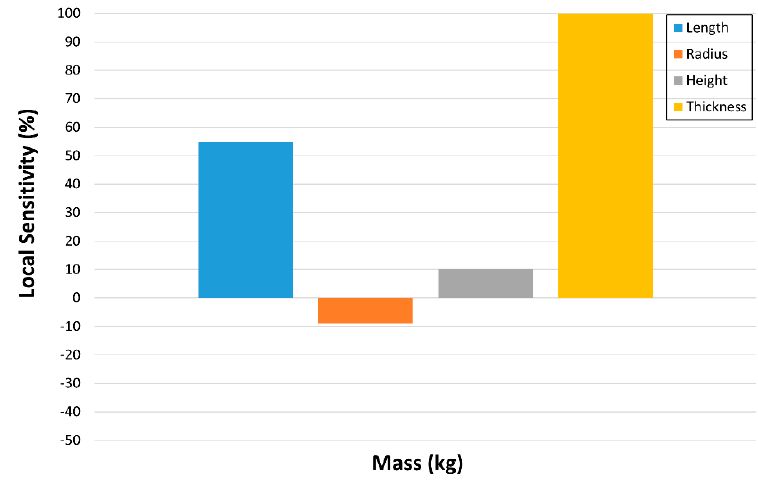
Figure 7. An example of a sensitivity analysis diagram.